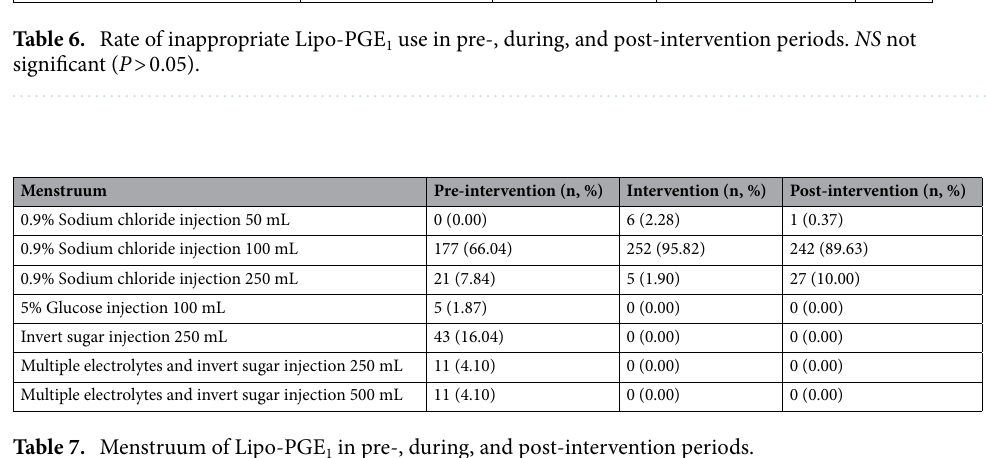
Table 6. Rate of inappropriate Lipo-PGE 1 use in pre-, during, and post-intervention periods. NS not significant ( P > 0.05).